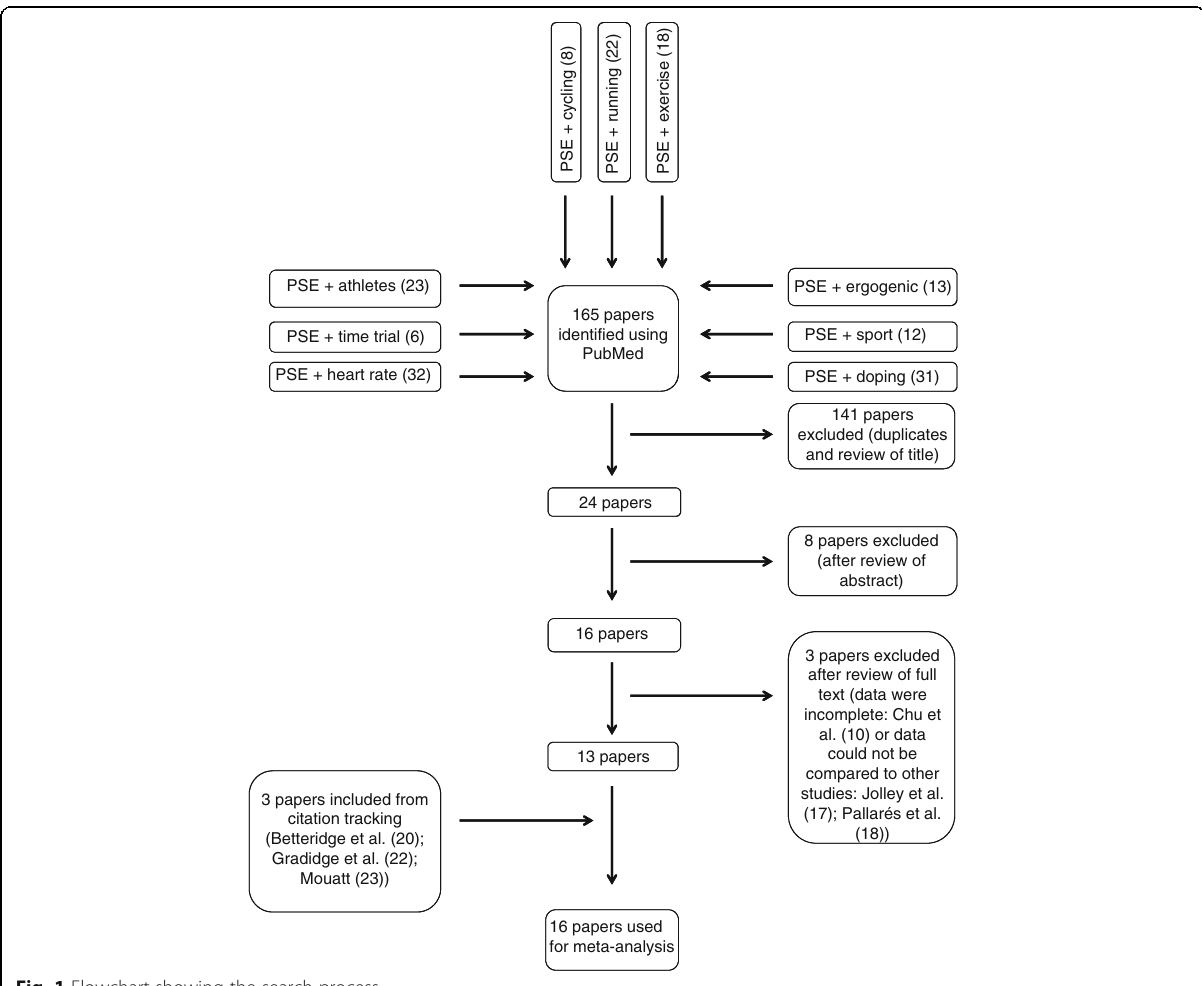
Fig. 1 Flowchart showing the search